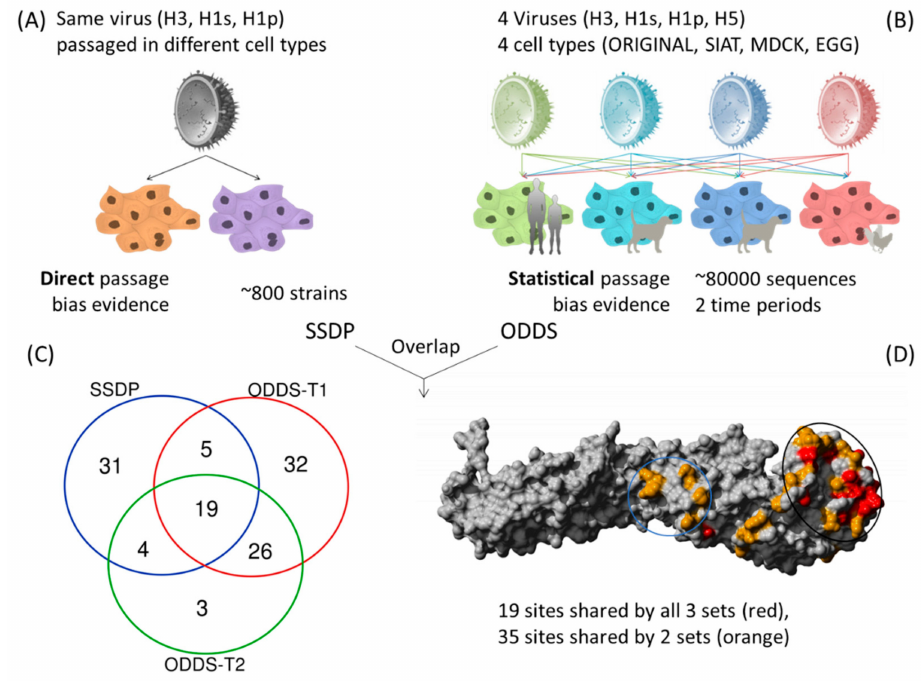
Figure 2. Approach and data types for identification of common passage bias sites. ( A ) Direct evidence from same strain with di ff erent passage (SSDP), ( B ) geometric mean of odds ratios > 5 from large statistical analysis over two time periods, ( C ) Venn diagram of overlap between SSDP and ODDS sets from two time periods. 54 sites are found in at least 2 of these sets of analyses, ( D ) Structural positions of dominant passage bias sites in HA. Black circle indicates receptor binding head region (i). Blue circle shows region undergoing pH dependent structural changes during fusion (ii). A third identified passage region is not shown as it is in the unstructured signal peptide region